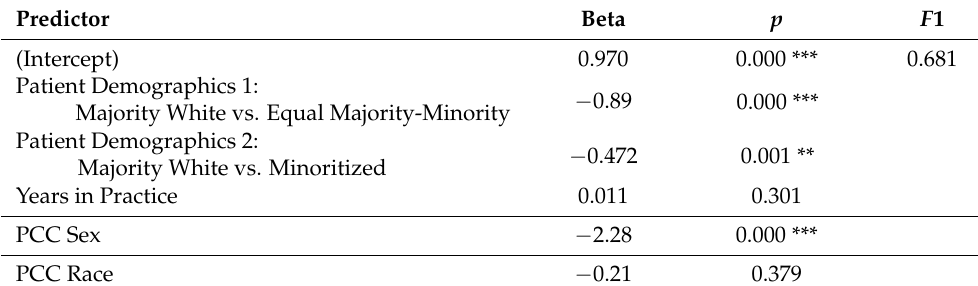
Table 5. H2: PCC and Practice Characteristics